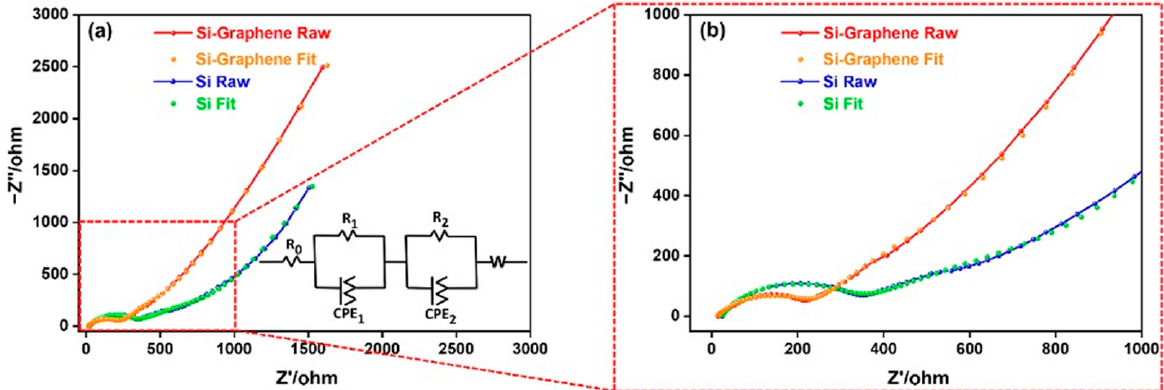
Table 1. EIS parameters of the Li/Si and Li/Si-graphene coin cells. EIS Parameter